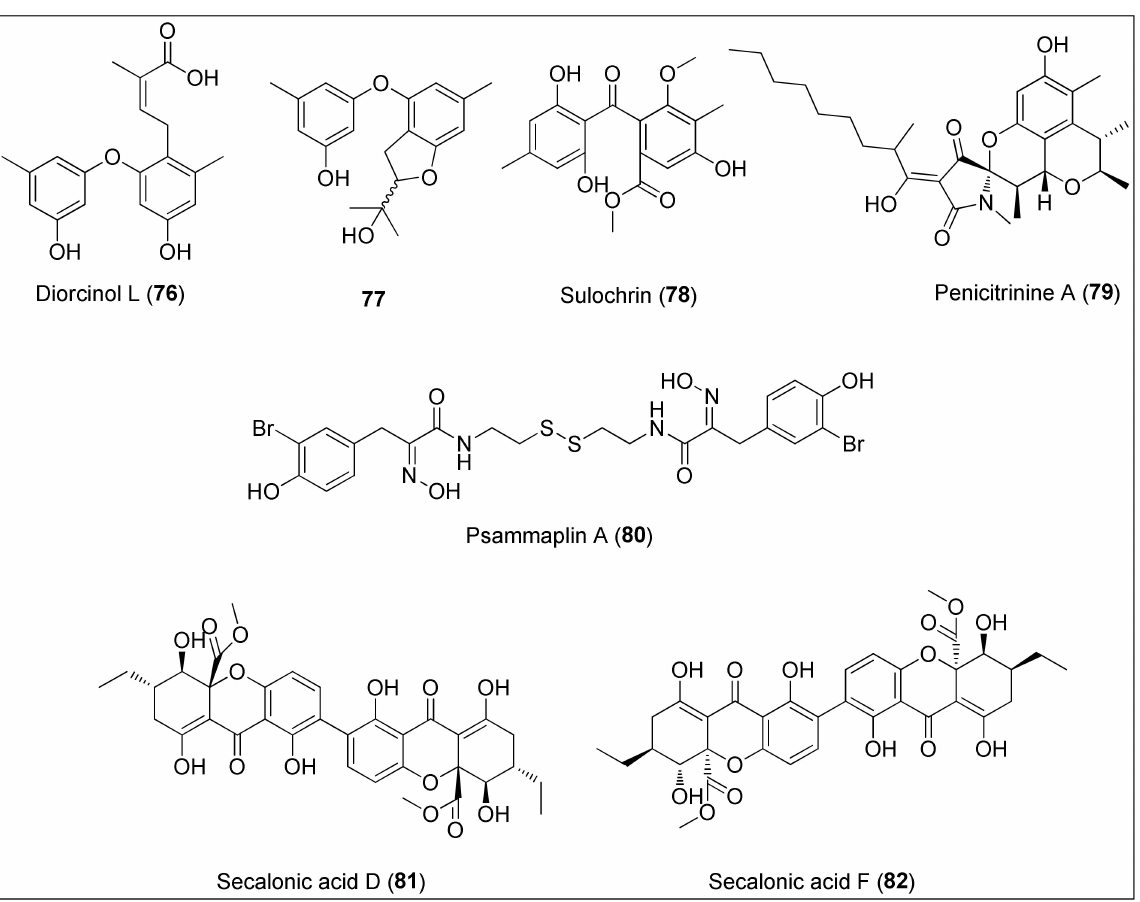
Figure 8. Diorcinol L ( 76 ) isolated from the fungus of the genus Didymellaceae and its derivative 77 , sulochrin ( 78 ) obtained from the fungus Aspergillus falconensis , penicitrinine A ( 79 ) isolated from the Penicillium citrinum , psammaplin A ( 80 ) extracted from the marine sponge of the genus Pseudoceratina , and secalonic acids D ( 81 ) and F ( 82 ) obtained from Penicillium sp. and Aspergillus aculeatus